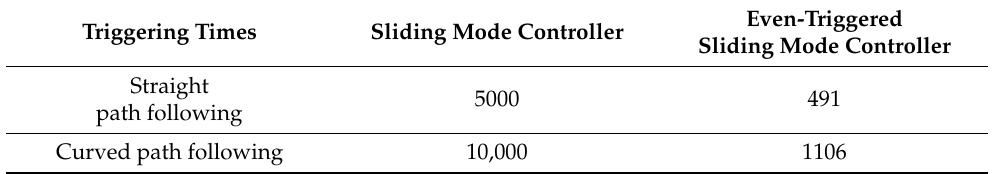
Table 1. The comparative results on triggering